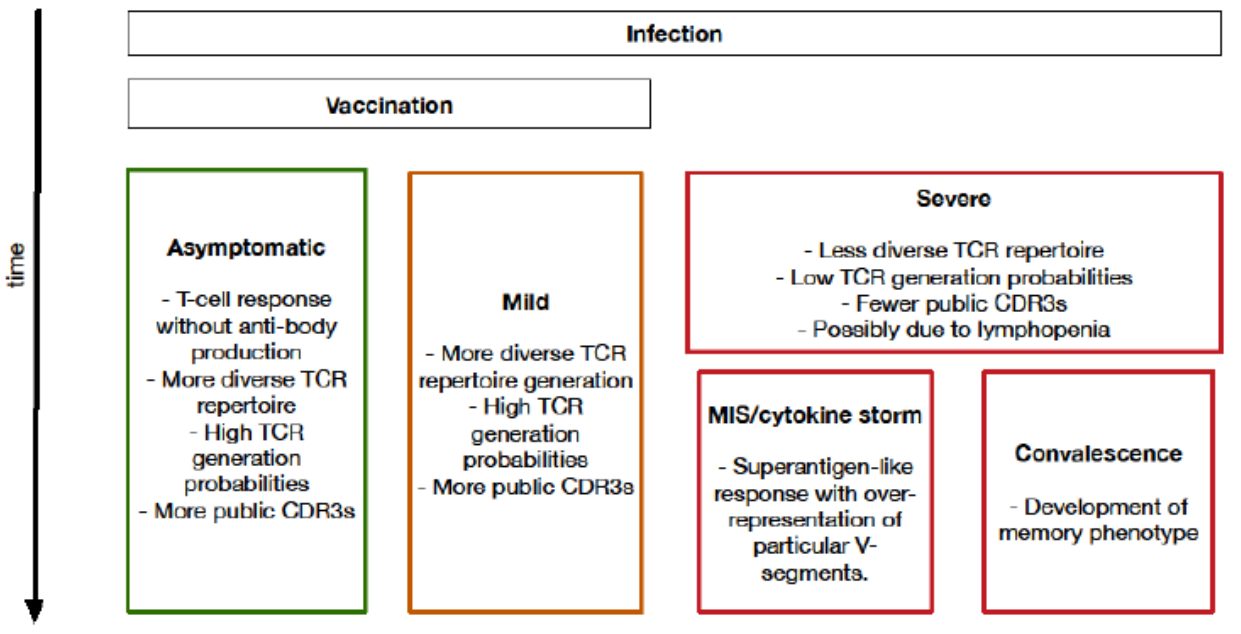
Figure 3. Schematic overview of insights into TCR repertoire, observed over time after infection, obtained by bulk TCR repertoire sequencing. MIS: Multisystem Inflammatory Syndrome.